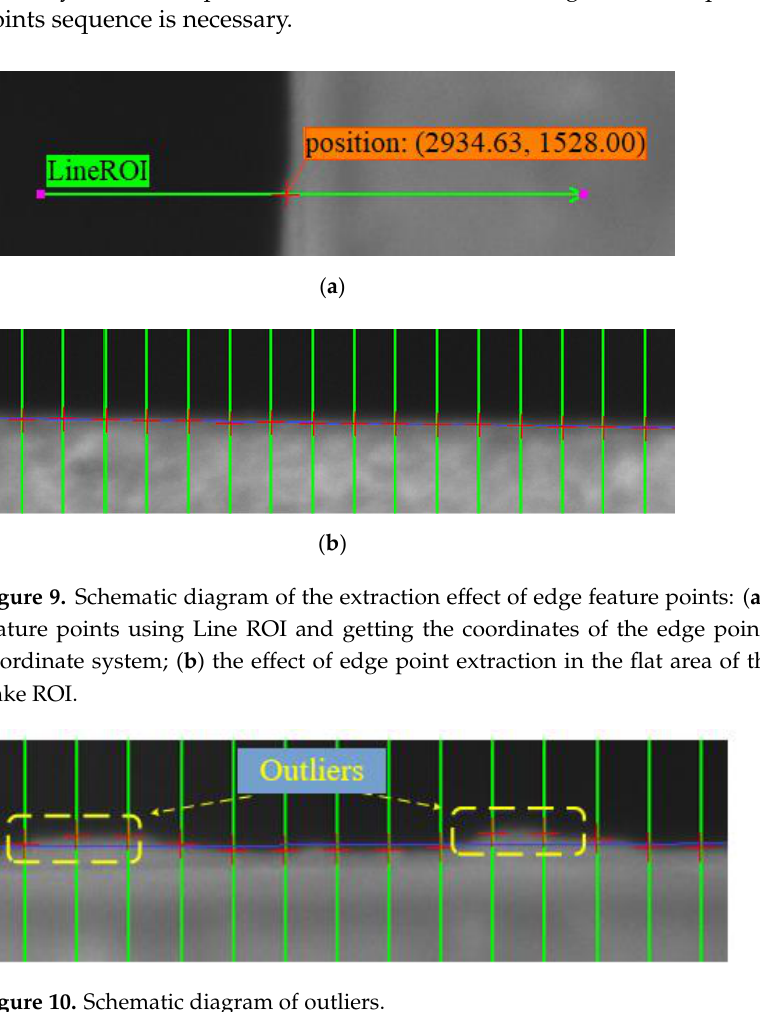
Figure 10. Schematic diagram of outliers.